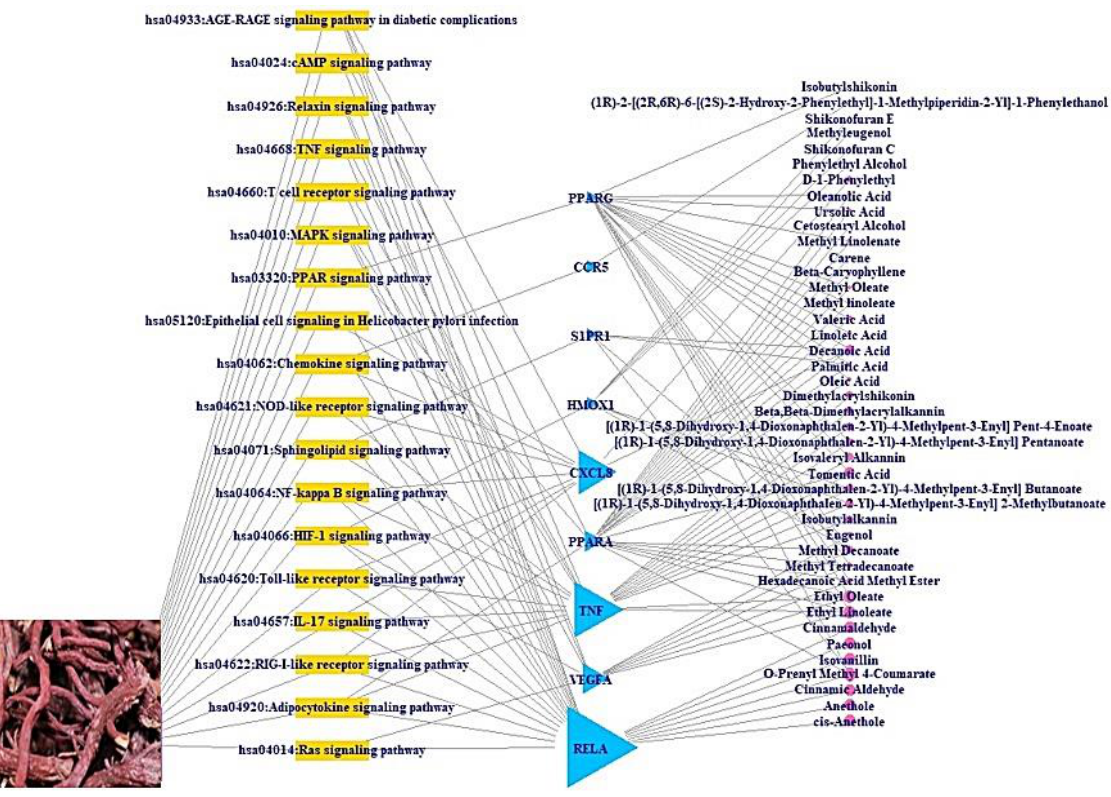
Figure 6. The STB networks. Yellow triangle: signaling pathway; blue sky triangle: target; pink circle: LE bioactive compound.